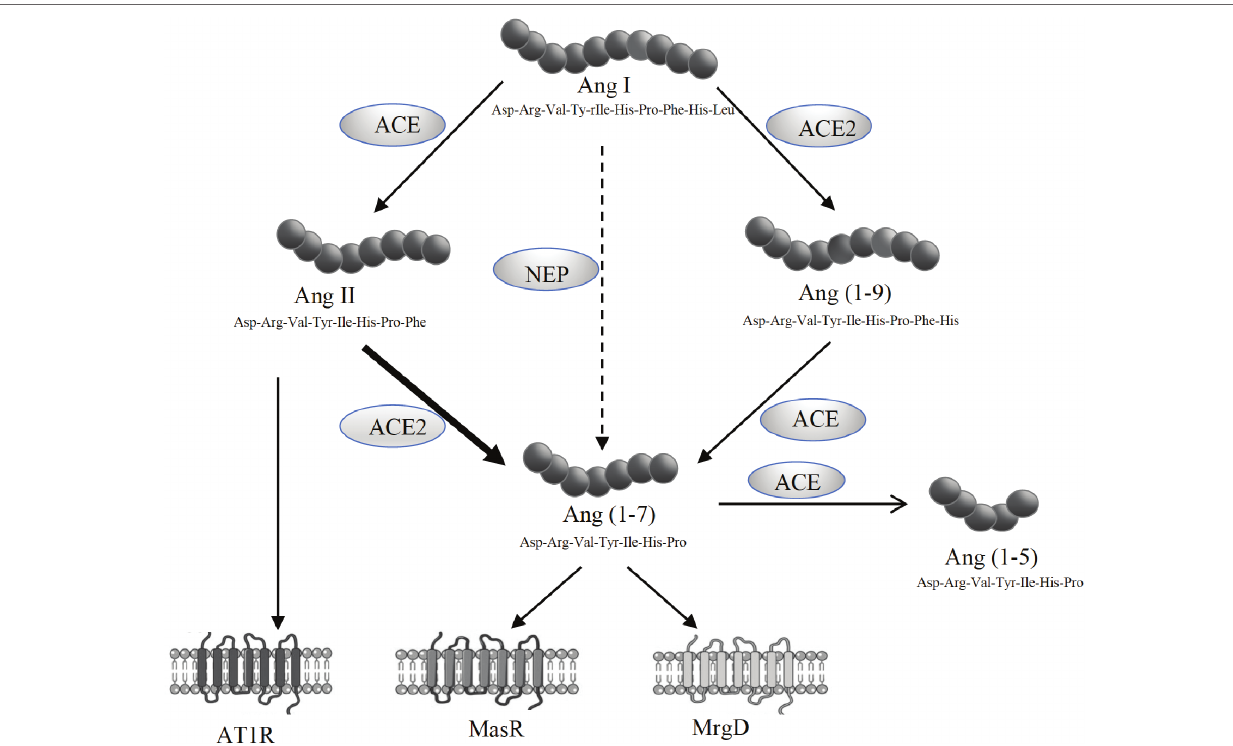
FIGURE 1 | Schematic representation of the renin angiotensin system (RAS) showing the pathways responsible for the generation of angiotensin II (Ang II) and angiotensin-(1-7) [Ang-(1-7)]. Ang II acts via its type 1 receptor (AT1R) to exert vasoconstrictive effects. Ang II is degraded to Ang-(1-7) by angiotensin converting enzyme 2 (ACE2). Ang-(1-7) opposes Ang II effects through its receptors, MasR and